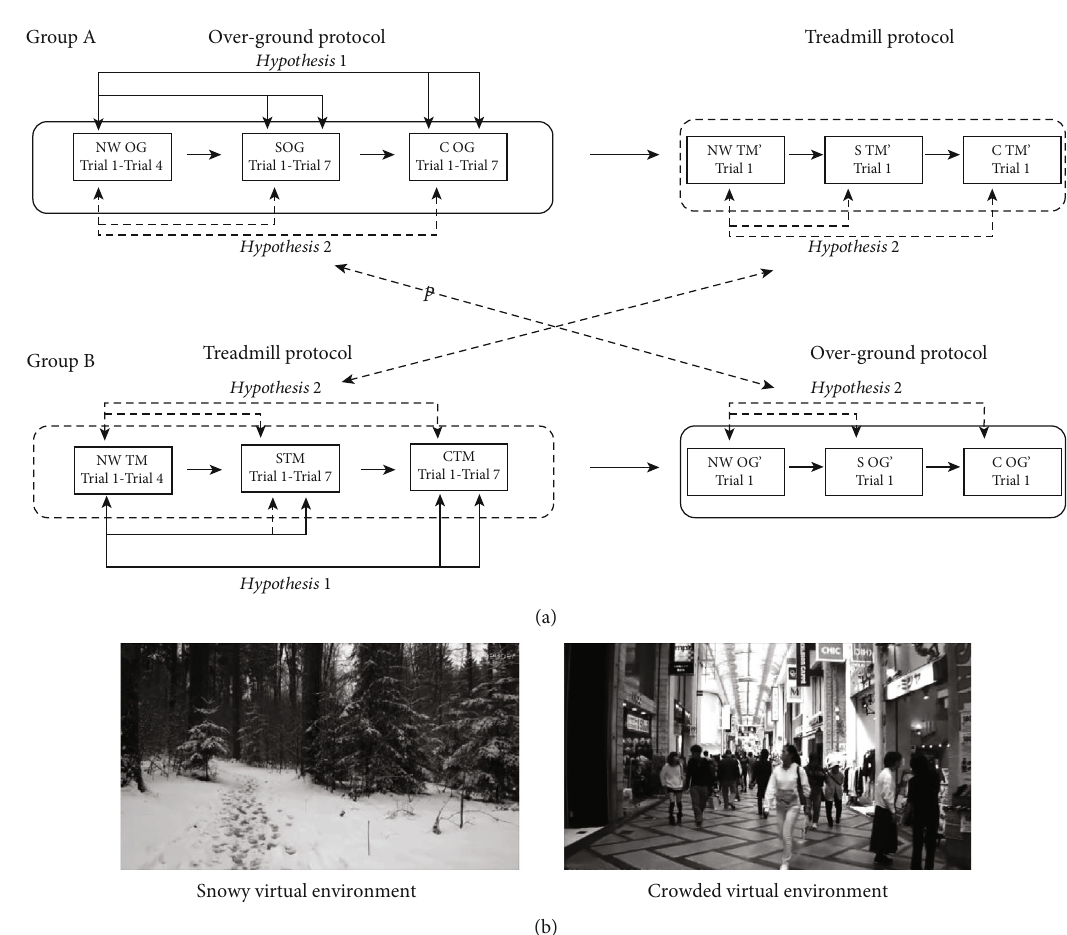
Figure 1: (a) Schematics of study design. Two groups (Group A and Group B) experienced VR protocol training over-ground and on a treadmill. Group A performed the VR over-ground protocol that included 4 natural walking (NW) trials, seven snowy (S) VRE trials, and seven crowded (C) VRE trials, followed by a VR treadmill protocol that included one NW trial, one S trial, and one C trial. Group B performed the VR treadmill protocol that included four NW trials, seven S VRE trials, and seven C VRE trials, followed by a VR over- ground protocol that included one NW trial, one S VRE trial, and one C VRE trial. Initial adaptation to VRE with respect to NW trials was compared between groups to test hypothesis 1. Initial kinematic changes in response to the fi rst exposure to each VRE for each surface condition were compared between groups to test hypothesis 2. (b ) Still-frame from the snowy and crowded virtual environment